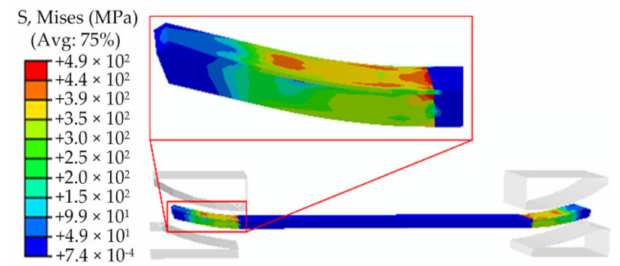
Figure 7. The Mises stress contour of the pre-bending after